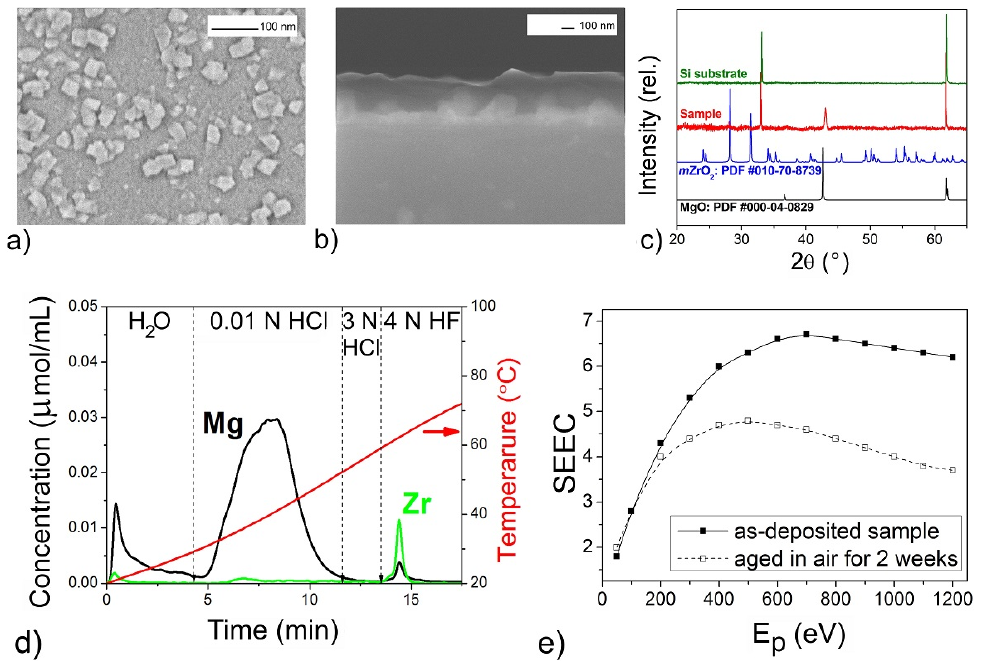
Figure 5. The mixed oxide film with n(Mg):n(Zr) = 11:1 according to DD data: SEM images ( a , b ), XRD pattern ( c ), DD curves ( d ), SEEC (Ep) curves ( e ).